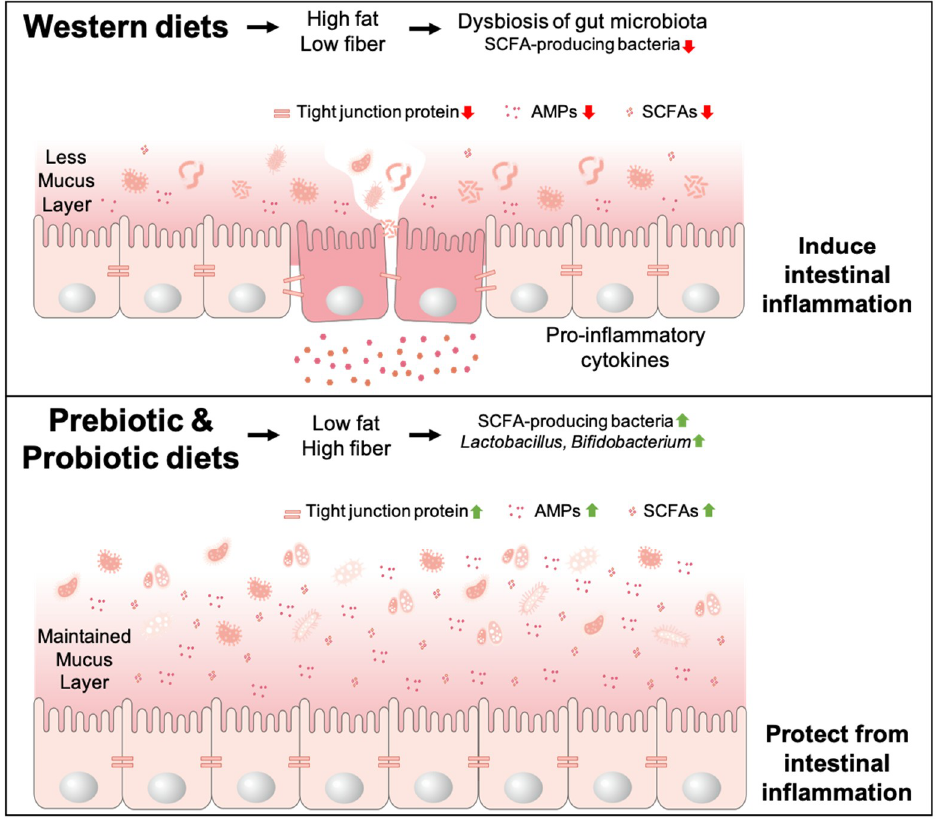
Figure 1. Diet alters gut microbiota associated with intestinal inflammation. Western diets containing high fat and lack of fiber changes gut microbiota population leading to a decrease of bacterial SCFAs, host AMPs, and mucus production as well as tight junction protein expression. Furthermore, it disrupts intestinal barrier, leads to bacterial translocation and increases pro-inflammatory cytokine production—resulting in intestinal inflammation. Meanwhile, prebiotic and probiotic diets provide a high fiber content, which increases the production of SCFAs, AMPs, mucus, and tight junction protein expression resulting in intact intestinal barrier and prevent from intestinal inflammation.